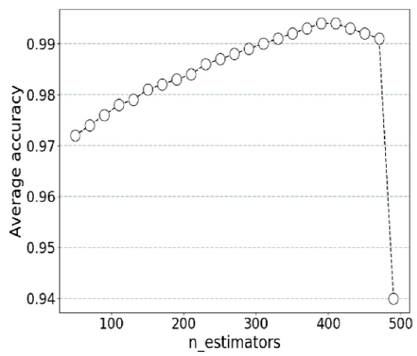
Figure 6. n_estimators and accuracy.